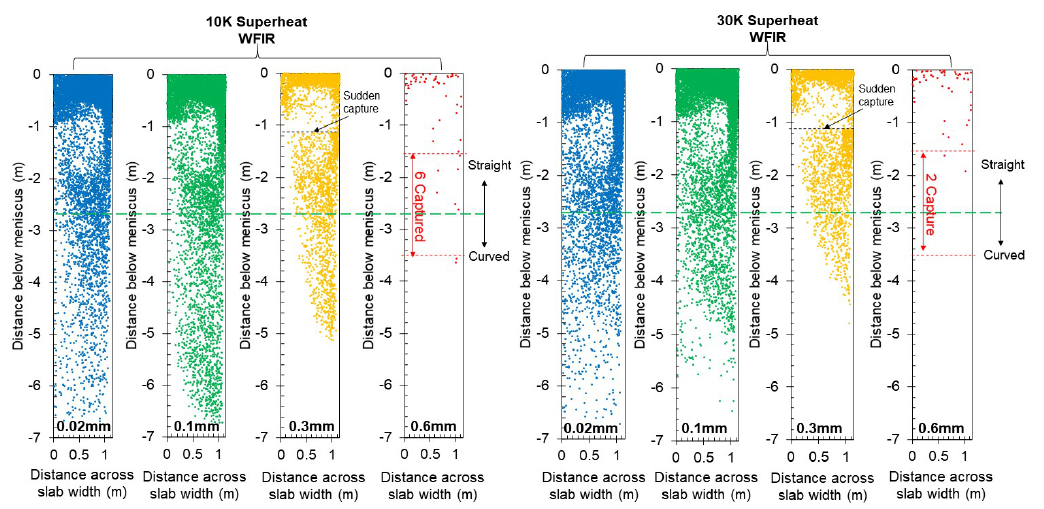
Figure 18. Capture and removal locations of selected bubble sizes: ( a – d ) capture endview; ( e – h ) removal top view; ( a , c , e , g ) 10 K superheat; ( b , d , f , h ) 30 K superheat.